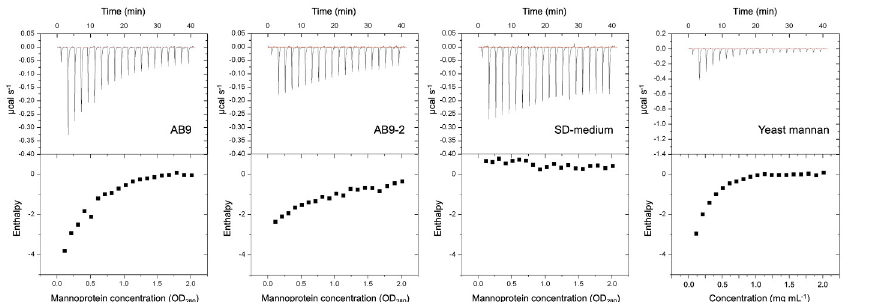
Fig 6. Interaction of YwfG 28–270 with yeast mannan proteins. Isothermal titration of YwfG 28–270 against (A) AB9 (wild type) mannoprotein, (B) AB9-2 ( mnm2 mutant) mannoprotein, (C) SD-medium, and (D) yeast mannan.